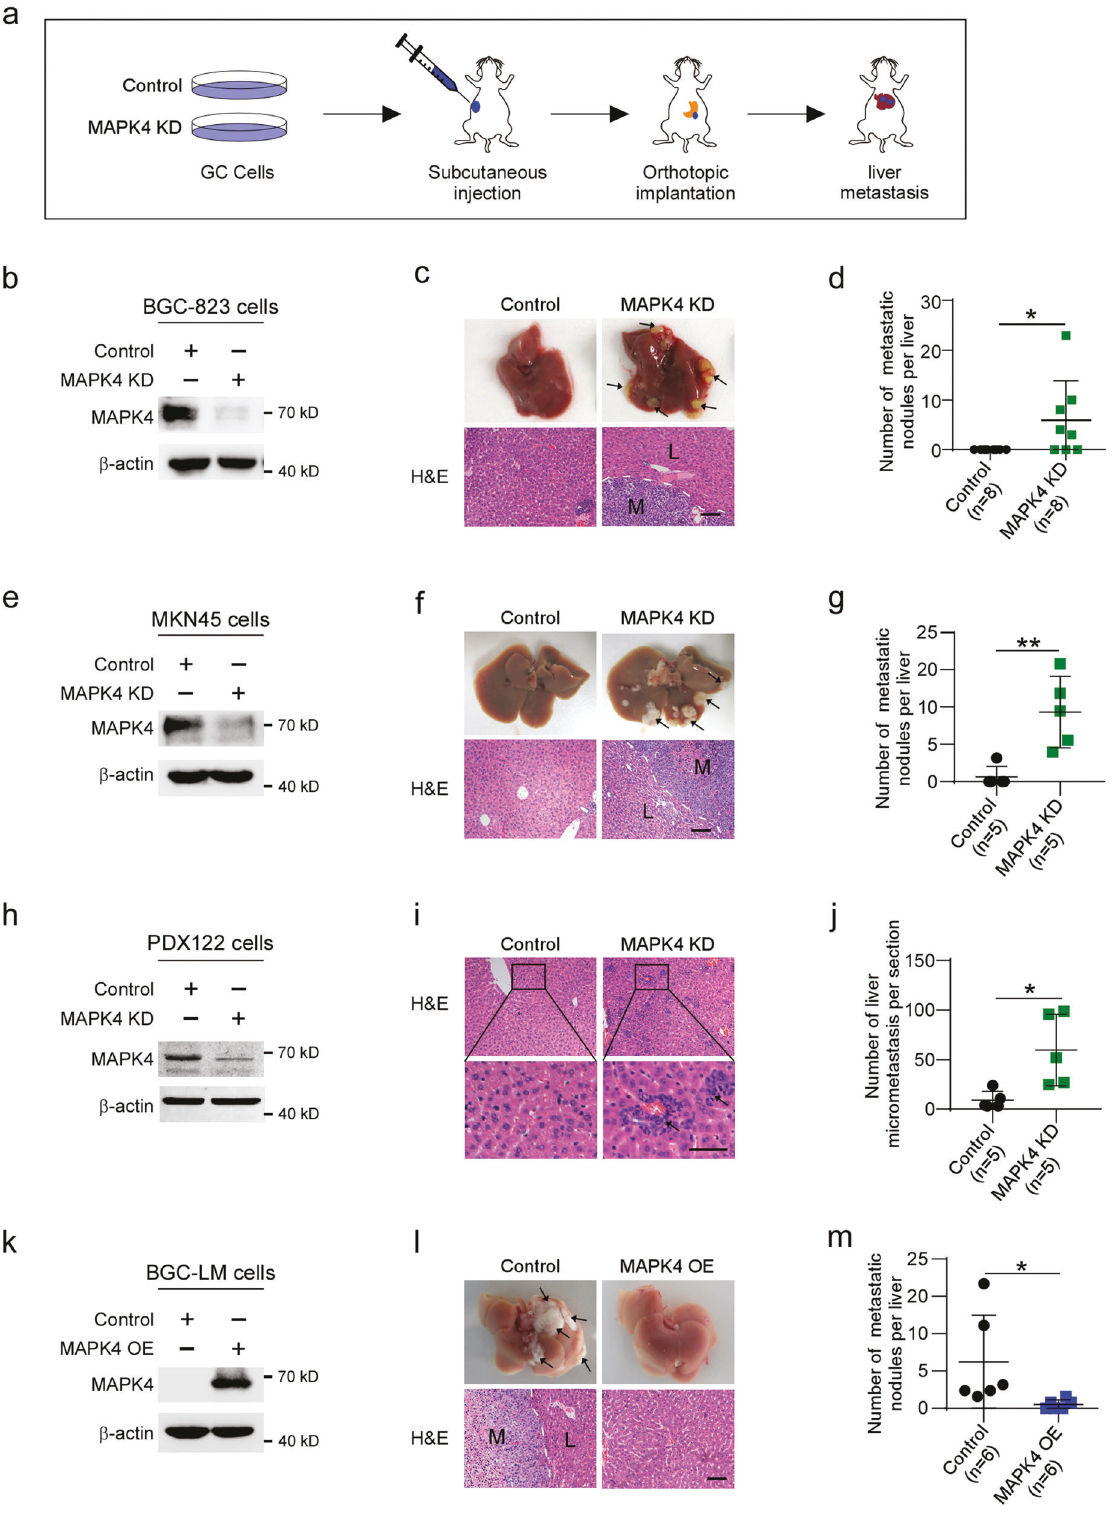
(Fig. 3g and Supplementary Fig. 4d). Thus, these fi ndings highlight that MAPK4 depletion in gastric cancer cells polarizes TAMs in an orthotopic tumor model. To determine whether macrophages mediate the function of MAPK4 in gastric cancer development, we generated a